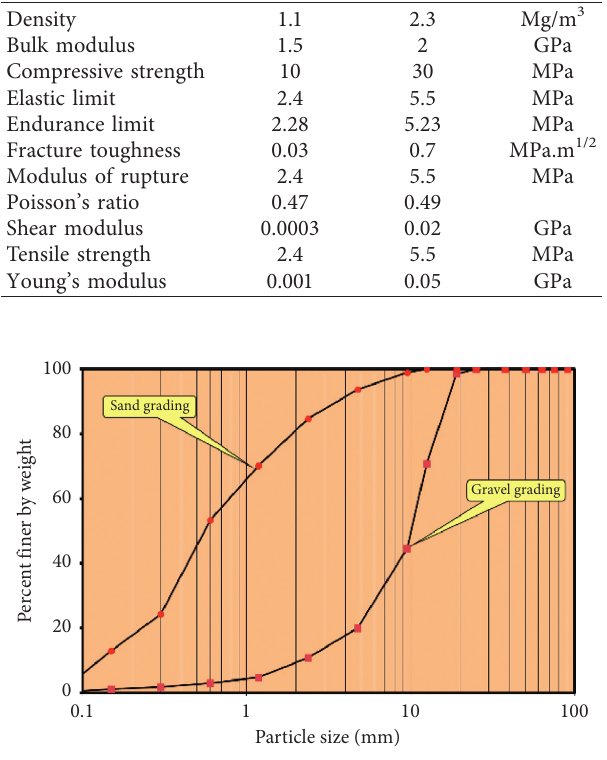
Figure 1: Grading of mineral